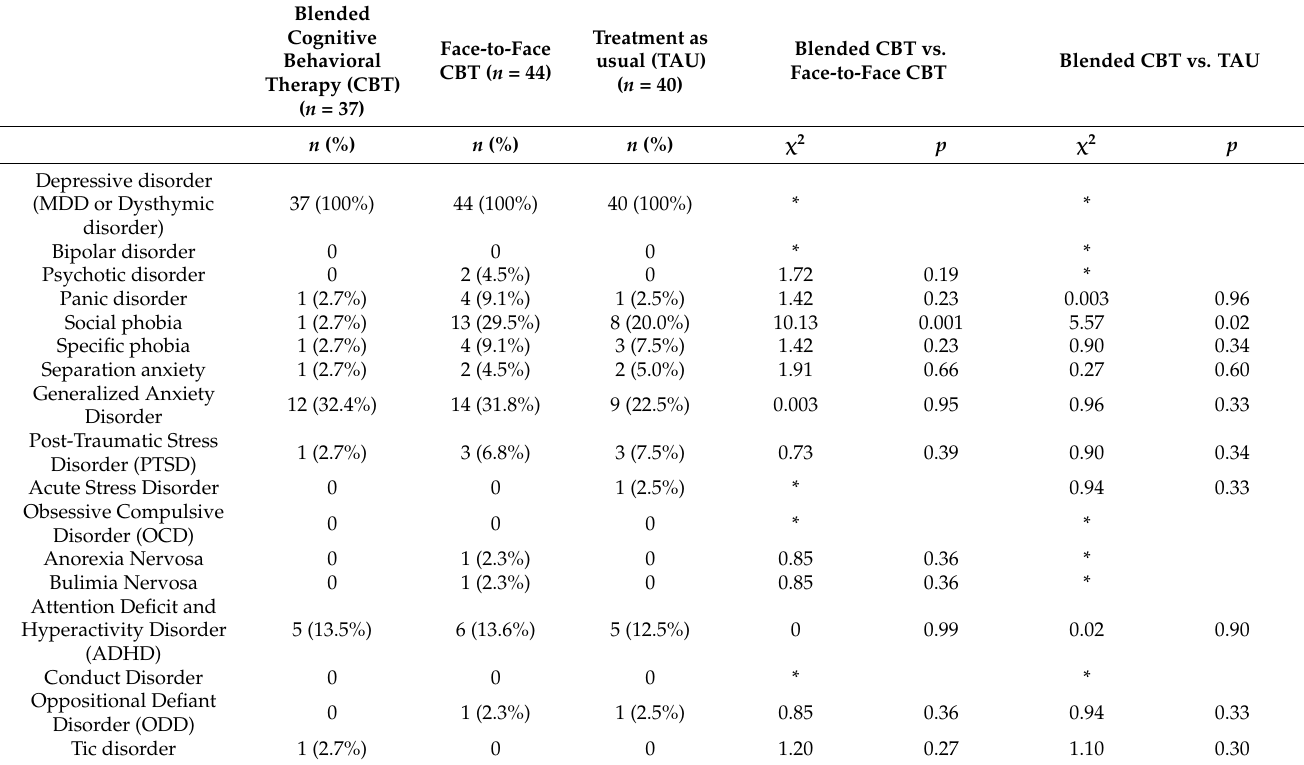
Table 1. Diagnostic sample